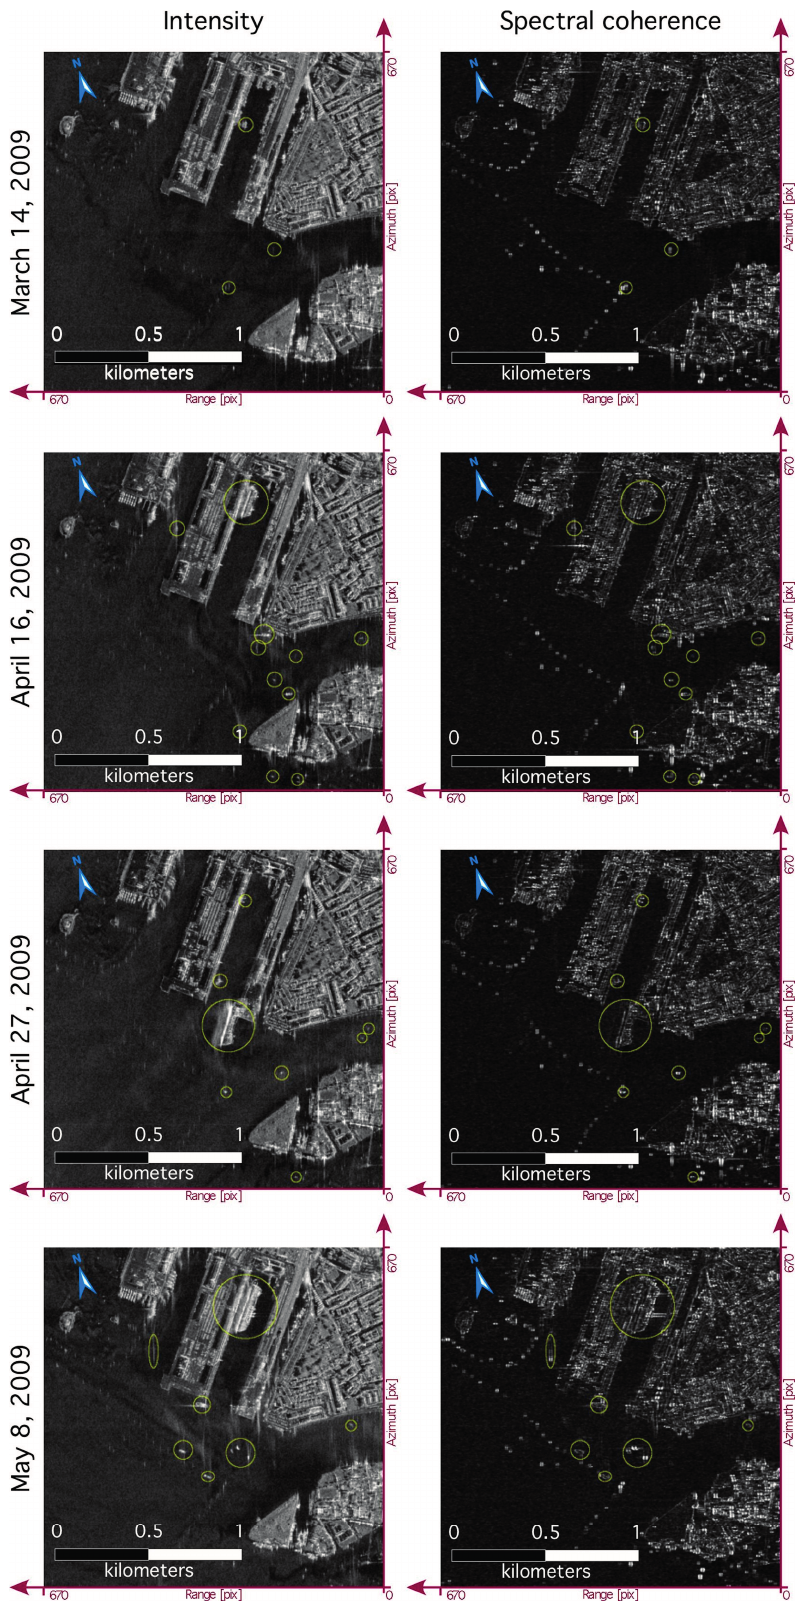
Figure 10. Intensity and spectral coherence for the four spotlight acquisitions. The maps are in SAR